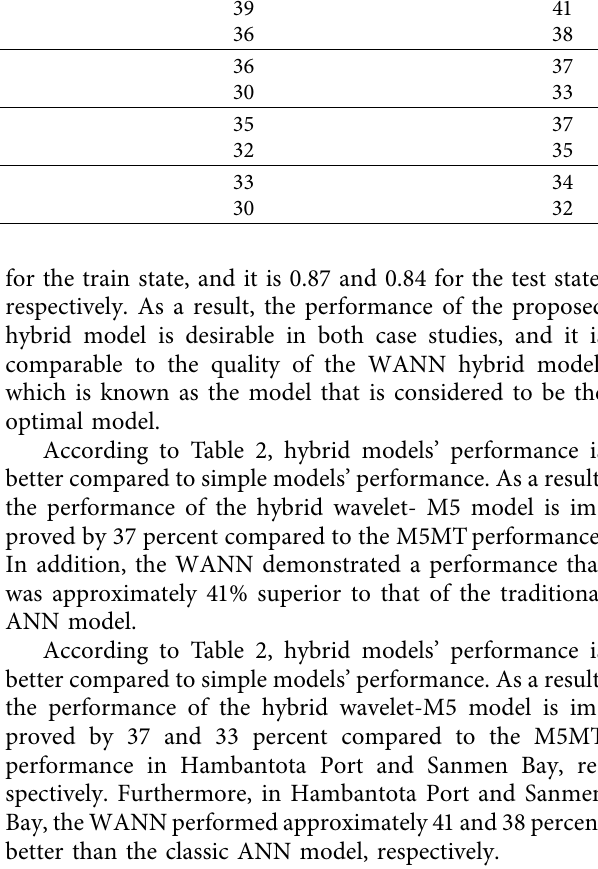
Table 2: Comparison of the hybrid models with ANN and M5MT (according to efciency criteria average). Model WANN vs.